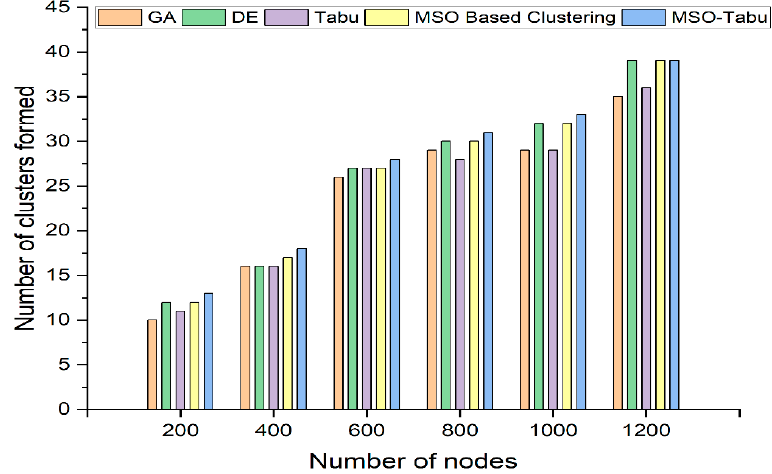
Sensors 2022 , 22 , x FOR PEER REVIEW Figure 1. Number of clusters formed for MSO-Tabu. Figure 1. Number of clusters formed for MSO-Tabu.